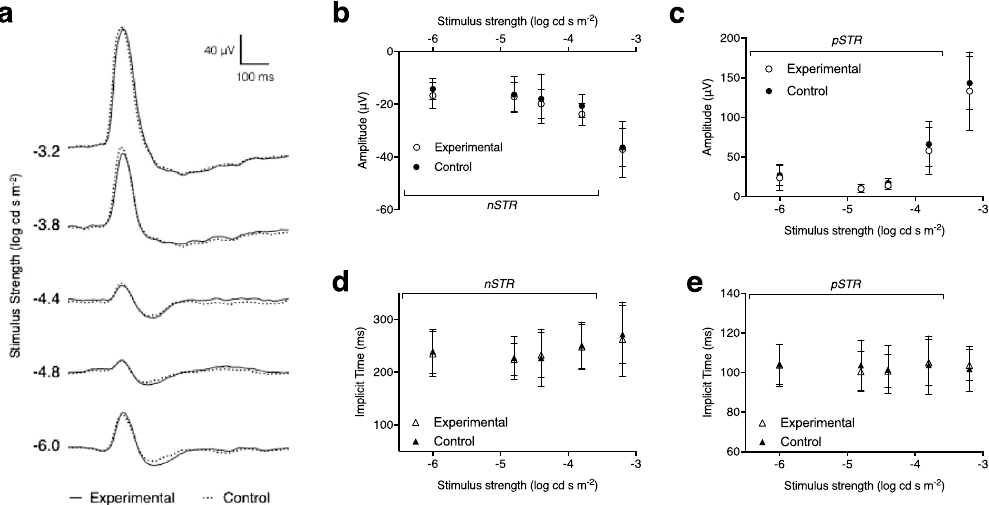
Figure 4. Effects of AAV2-DCX-GFP injection on the ERG 5-weeks post-injection. ( a ) Example waveforms of ERG recordings obtained from AAV injected experimental ( solid ) and control fellow ( dashed ) eyes over a range of low stimulus strengths. Averaged group data for control ( filled circles ) and experimental ( unfilled circles ) of ( b ) negative STR, ( c ) positive STR amplitudes. Averaged group data for control ( filled triangles ) and experimental ( unfilled triangles ) eyes of ( d ) negative STR implicit times, and ( e ) positive STR implicit times. No significant differences were found between the control and experimental eyes for any of the measures. Error bars represent 95% confidence interval; n = 6.